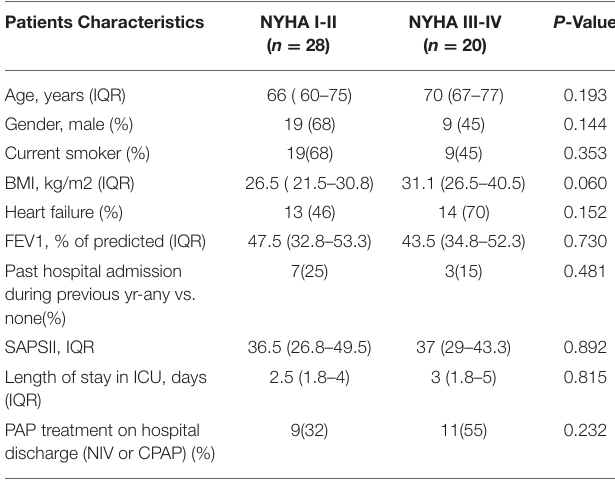
TABLE 1 | Baseline Characteristics of the study population* according to categorical classification of Dyspnea (NYHA I-II vs. NYHA III-IV). Patients